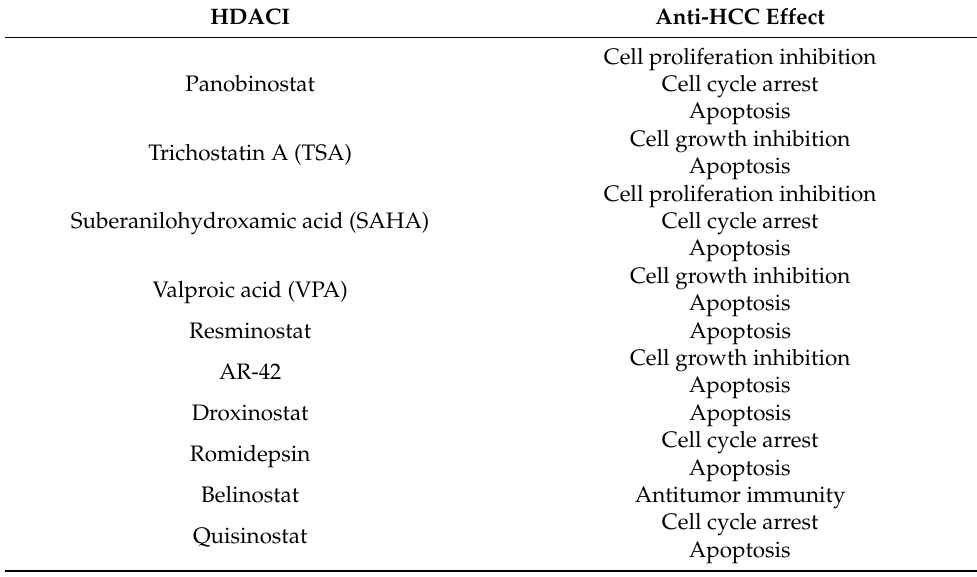
Table 2. Main histone deacetylase inhibitors with anticancer effects against hepatocellular